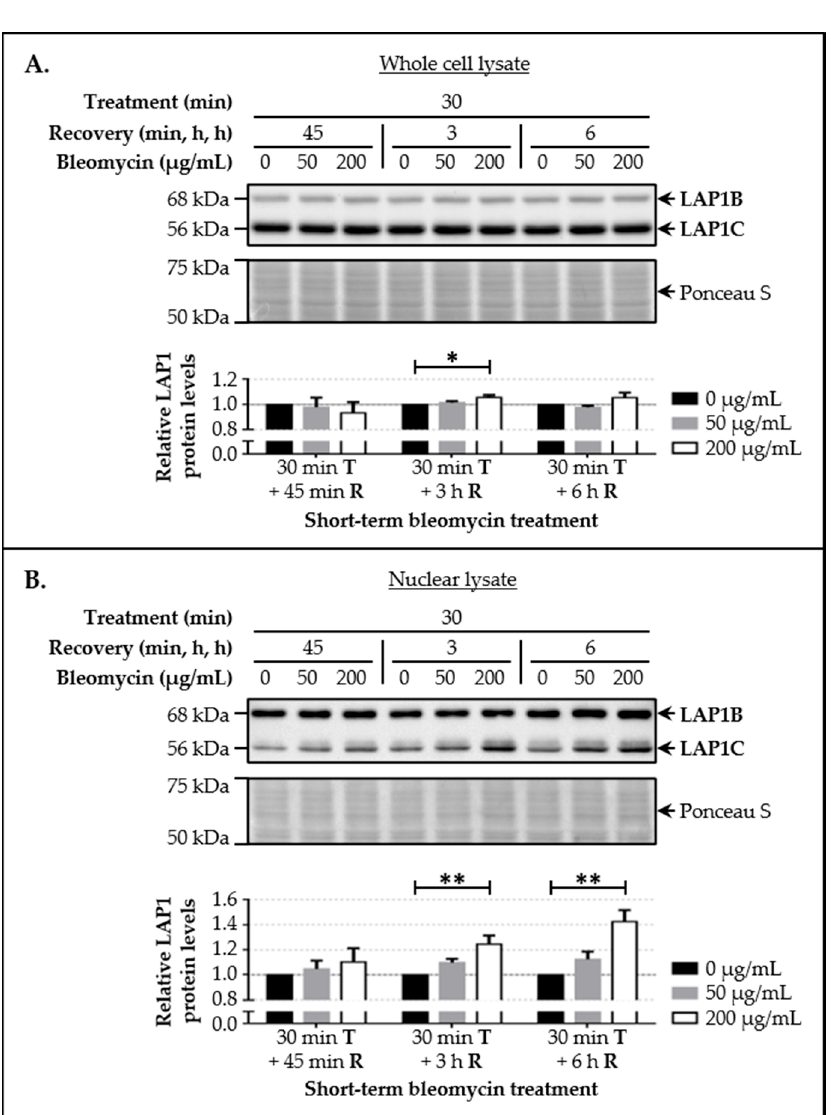
Figure 4. Evaluation of the effects of DNA damage induced by a short-term bleomycin treatment on LAP1 protein levels in the human HeLa cell line. ( A ) Relative LAP1 protein levels in whole cell lysates after cell exposure to 50 and 200 µg/mL of bleomycin for 30 min (T), followed by 45 min, 3 h and 6 h of recovery (R) (estimated in relation to untreated cells (0 µg/mL) at each timepoint). ( B ) Relative LAP1 protein levels in nuclear lysates in the same experimental conditions specified in ( A ). Following treatment, HeLa cells’ total and nuclear extracts were analyzed by immunoblotting using a LAP1-specific antibody to evaluate their protein levels. A representative blot is shown for each type of cellular lysate used. Quantitative data are presented as mean ± SEM ( n = 4). Before determining relative LAP1 protein levels, data normalization was performed using Ponceau S staining as protein loading control. * p < 0.05 and ** p < 0.01 for comparisons between control and treatment conditions using the Kruskal–Wallis test followed by the Dunn’s multiple comparison test. LAP1, lamina-associated polypeptide 1; SEM, standard error of the mean.